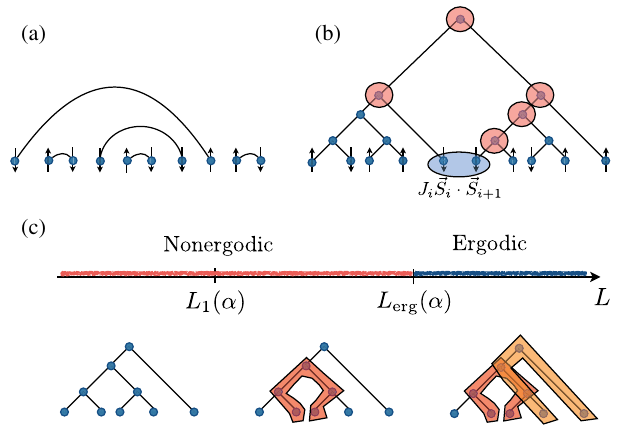
FIG. 1. (a) A cartoon of the ground state of a random anti- ferromagnetic Heisenberg chain. (b) The strong-disorder renorm- alization group aims to construct approximate eigenstates. It yields a tree state, characterized by its geometry and the choice of total block spins at each node (see the main text). The Heisenberg Hamiltonian, written in this basis, gives rise to processes which can change the spins along the “ causal ” path connecting two neighboring spins, to one of the block spins. (c) A schematic dynamical phase diagram of the random Heisenberg model. There are three regimes: (I) At short length scales L < L 1 ð α Þ , the SDRG tree states are accurate approximations of the eigenstates; (II) at α Þ , there are reso- intermediate length scales L 1 ð α Þ < L < L erg ð nances but the system remains nonergodic; (III) above some large α Þ , the resonances proliferate and the length scale L > L erg ð system becomes thermalizing (see Secs. IV B and IV C for a definition of these